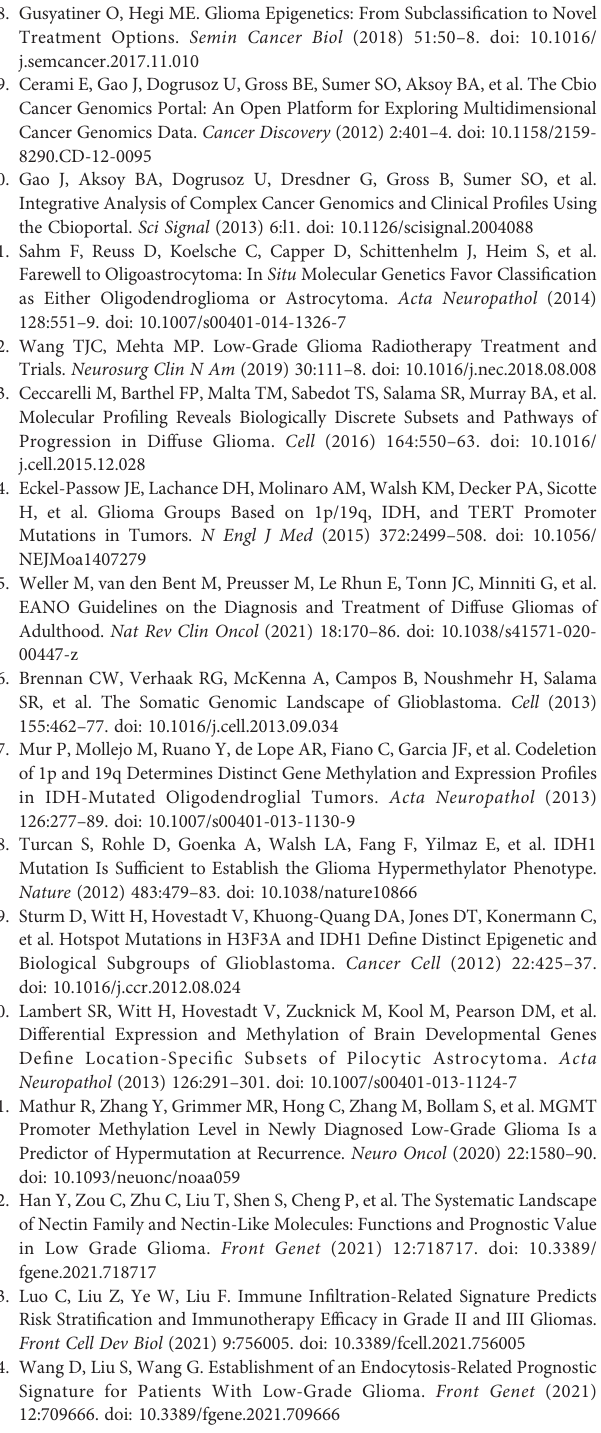
Supplementary Figure 1 | Comparative coexpression of PREX1 with members ofitssignalinghubsignatureamong32TCGAstudies.Coexpressionof PREX1 with genes coding for members of the PREX1 signaling hub signature was analyzed in the 32 TCGA studies in the cBioPortal platform. The fi gure shows the comparative coexpression lists displayed based on the Spearman ’ s correlation coef fi cients to present those with highest values at the top-left.